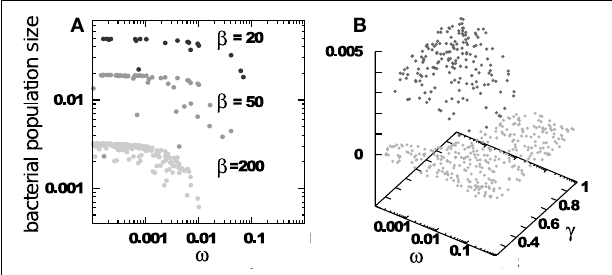
FIGURE 2 | Final distribution of surviving bacteria when starting with 500 bacterial strains, each having an RM system with strength ω i ∈ [ 0 . 0001 : 1 ] , growth rate γ i ∈ [ 0 . 2 : 1 ] . Phage adsorption and decay rates are η i 1 and δ i 0 . 2 . The burst sizes vary as indicated. (A) Shows = = bacterial populations vs. RM strengths. (B) Shows bacterial populations vs. RM strengths and bacterial growth